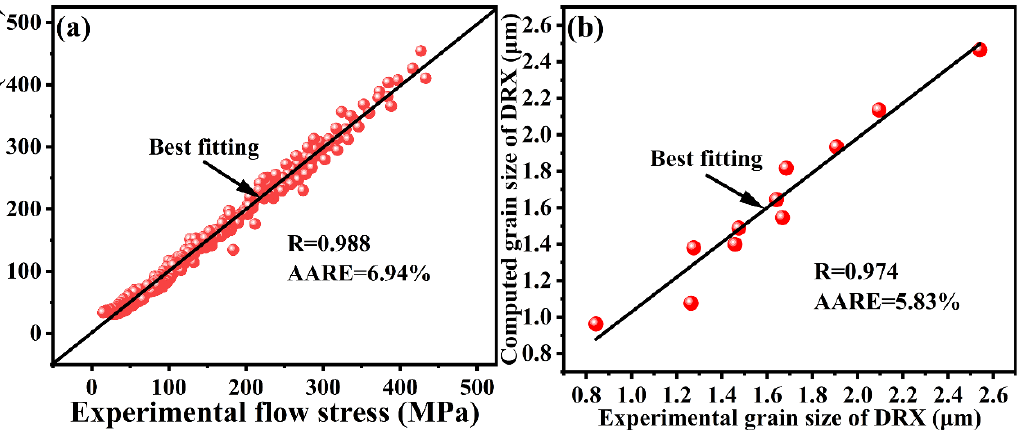
Figure 13. Correlation of the experimental and the predicted values: ( a ) true stress and ( b ) AGS of DRX.